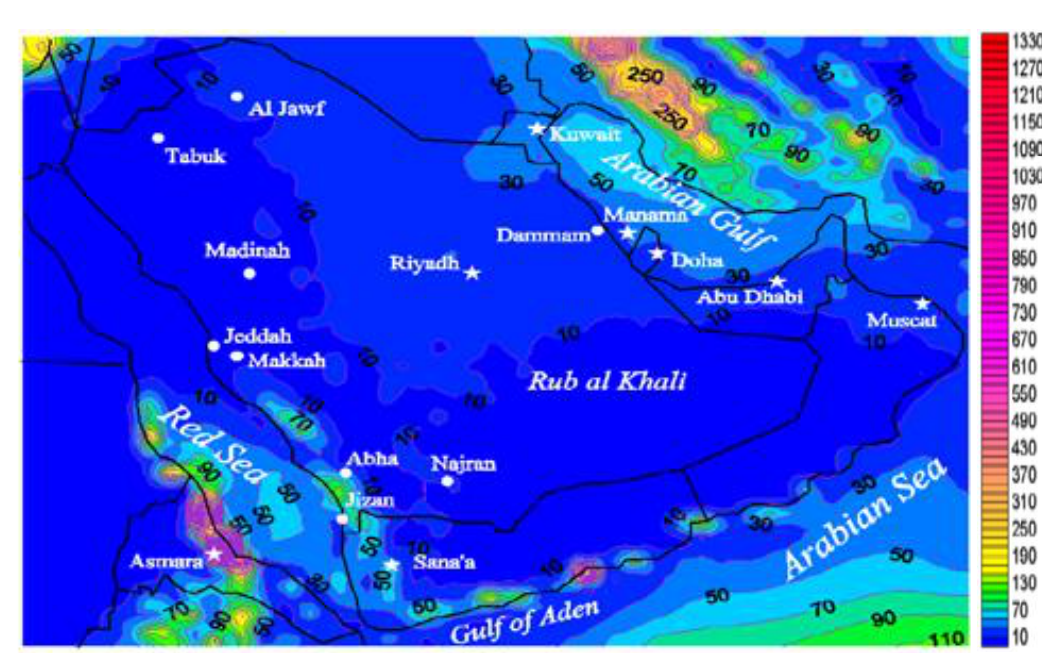
Figure 21. The spatial distribution pattern of the mean total winter precipitation over the 2070-2100 period [39].